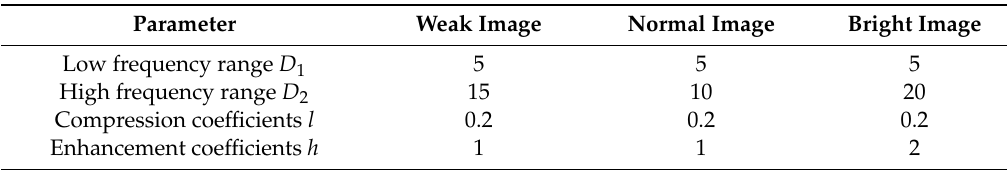
Table 1. Parameter setting in this